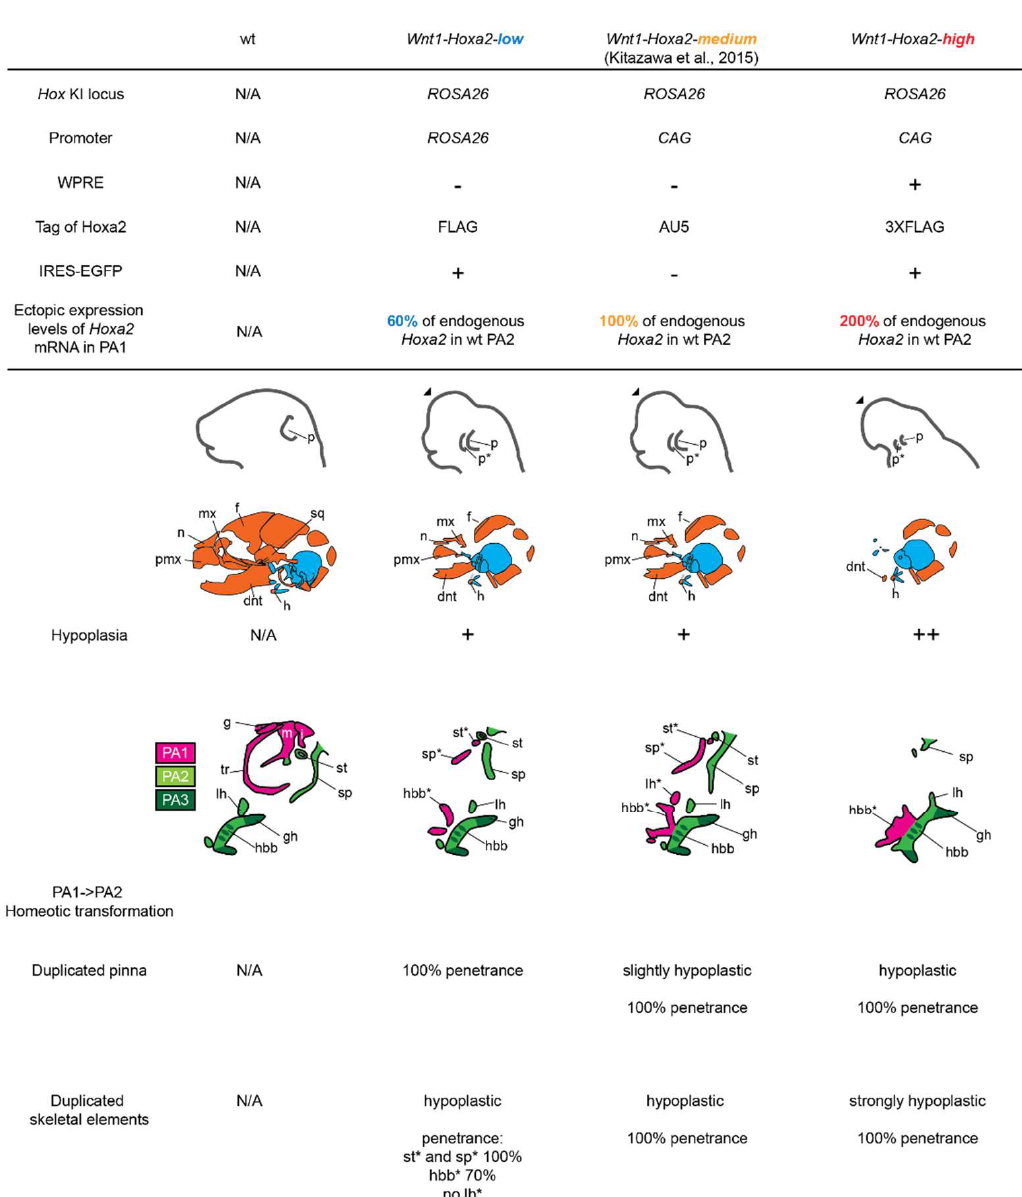
Figure 4. Craniofacial phenotypes induced by distinct ectopic Hoxa2 expression levels. (Upper rows) Design of the Wnt1::Cre -dependent conditional Hoxa2 overexpression allele Wnt1-Hoxa2-low , Wnt1-Hoxa2-medium [16] and Wnt1-Hoxa2-high . Hoxa2 knock-in loci, promoters, presence of WPRE, protein tags, IRES-EGFP and Hoxa2 mRNA levels in PA1, as compared with endogenous levels in wild-type (wt) PA2, are indicated. (Lower rows) Comparison of hypoplastic craniofacial phenotype and homeotic transformation of proximal PA1 into PA2-like derivatives from the distinct alleles, as indicated. Skeletal elements derived from PA1 (magenta), PA2 (light green) and PA3 (dark green) cranial neural crest cells (CNCCs) are indicated. Penetrance of PA1 to PA2 repatterning phenotypes is indicated for the different alleles. dnt, dentary; f, frontal; g, gonial; gh, greater horn of hyoid bone; h, hyoid bone; hbb, body of hyoid bone; i, incus; lh, lesser horn of hyoid bone; m, malleus; mx, maxillary; n, nasal; p, pinna; pmx, premaxillary; PA, pharyngeal arch; sp, styloid process; sq, squamosal; st, stapes; tr, tympanic ring; *, duplicated structure.